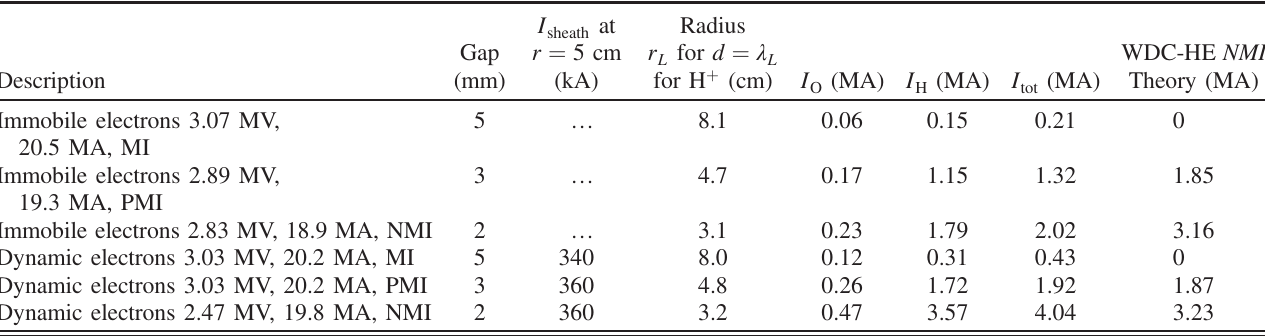
TABLE III. Summary of the two ion species, 2D EM simulation results. All cases use an H þ fraction of 2 = 3 , giving and an ion emission region extending between r ¼ 3 cm and 7